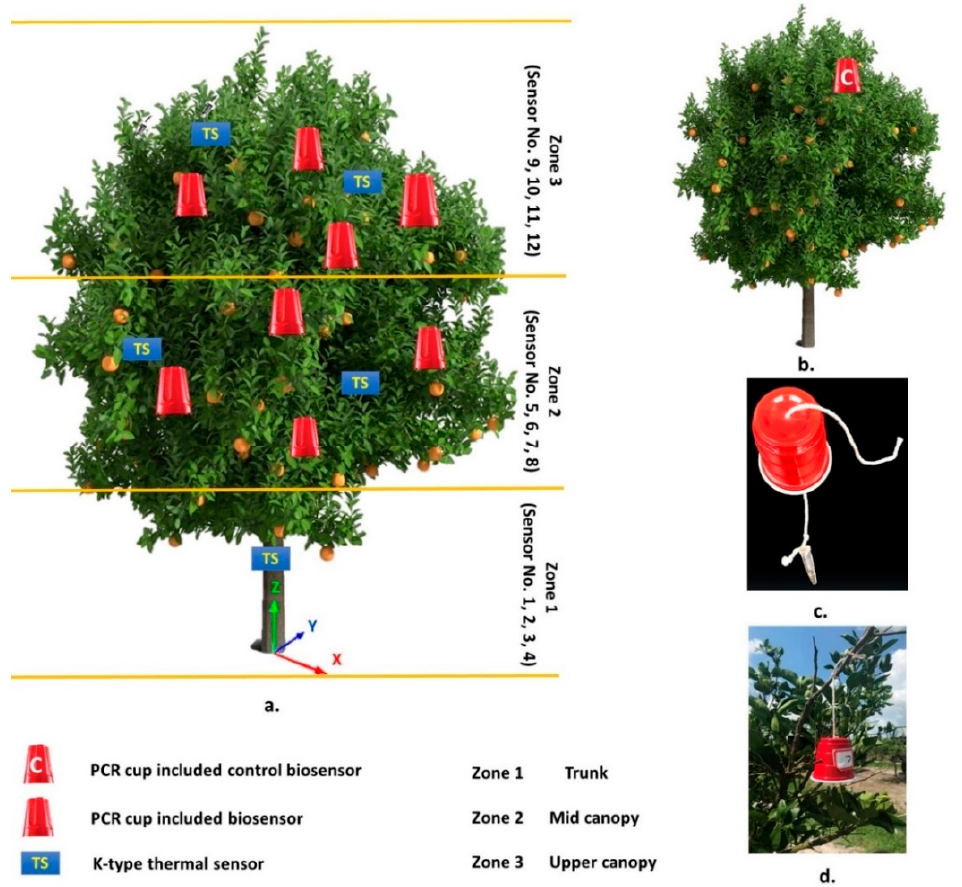
Figure 2. a . Schematic diagram of the thermal sensors and biosensors (red cups with cultures) positioning within the three zones (six of the thermocouples are visible in Figure 2a, and six of them are installed in the other side of the tree and not visible in Figure 2a.). b . Schematic diagram and location of control biosensor. c . Biosensor culture attached to the cup prior to installation on the target tree. d . Control biosensor installed on a non-treated tree. Table 1. Thermal sensor coordinates (The center of the tree trunk is considered as the origin of the coordinates, as shown in Figure 2a.).